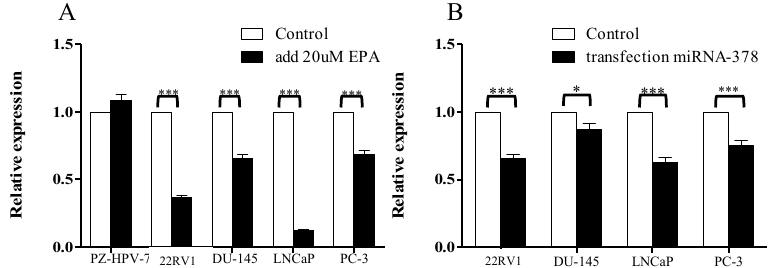
Figure 7. Cell viability significantly decreased after PCa cells were treated with EPA. ( A ) After the addition of 20 µ M of EPA to all the PCa cells, the flow cytometry analysis indicated significantly increased cell death; ( B ) MTS analysis showed that after transfection with mimic miR-378, the cells also presented significant cell death. * represents p value < 0.05; *** represents p value <